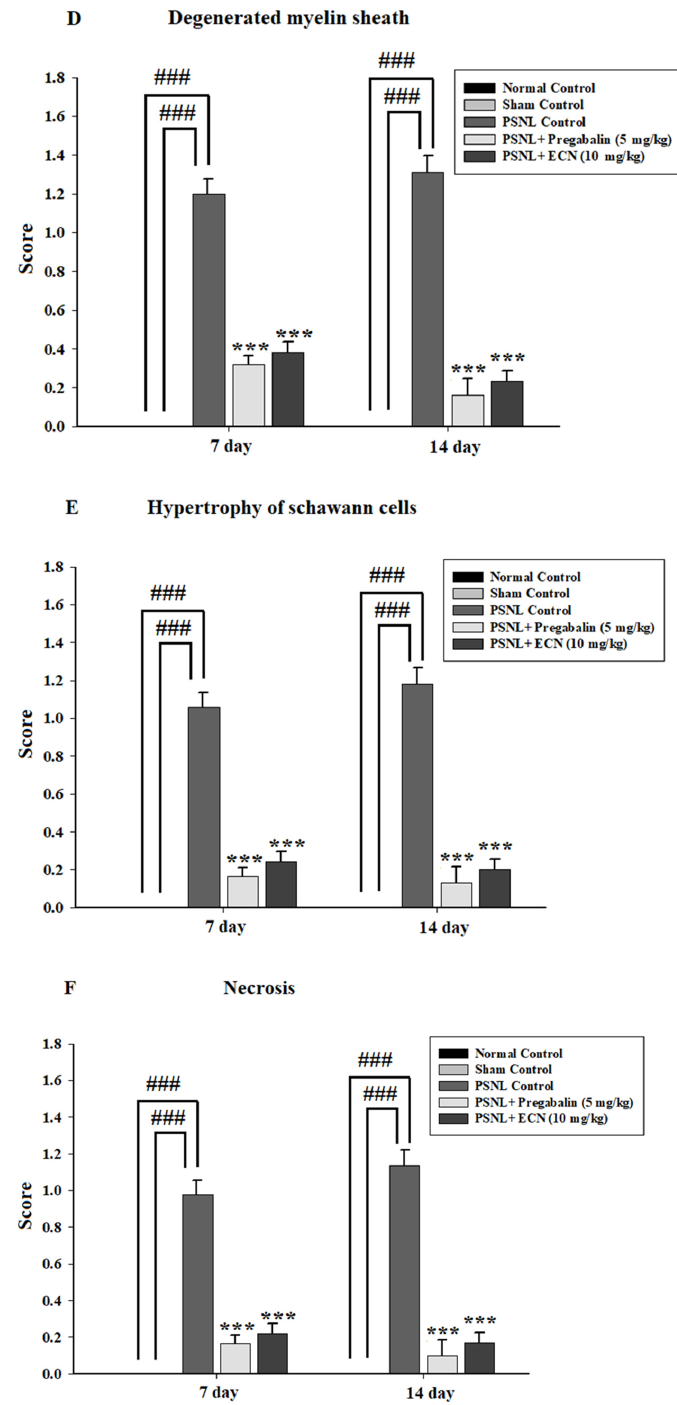
Figure 5. Effect of ECN (10 mg/kg) on the pathological histology of sciatic nerve tissue. The sciatic nerve of mice subjected to PSNL is shown in longitudinal sections stained with hematoxylin and eosin at 10 × magnification (scale bar 50 μ m). ( A ) Pathological histology of sciatic nerve tissue on day 7 post-PSNL surgery. ( B ) Pathological histology of sciatic nerve tissue on day 14 post-PSNL surgery. ( C ) Swelling of nerve fiber on 7 and 14-day post-PSNL surgery. ( D ) Degenerated myelin sheath on 7 and 14-day post-PSNL surgery. ( E ) Hypertrophy of Schwann cells on 7 and 14-day post-PSNL surgery. ( F ) Necrosis on 7 and 14-day post-PSNL surgery. Black arrowhead shows swelling of nerve fiber, red arrowhead shows degenerated myelin sheath, blue arrowhead shows hypertrophy of Schwann cells and green arrowhead shows necrosis. The data is presented as the mean (n = 3) ± S.D. Different letters meant statistically significant differences: (***) p < 0.001 indicate significant differences from the PSNL control group. (###) indicate significant differences from the normal control group. *** p < 0.001 (two-way ANOVA followed by Dunnett’s